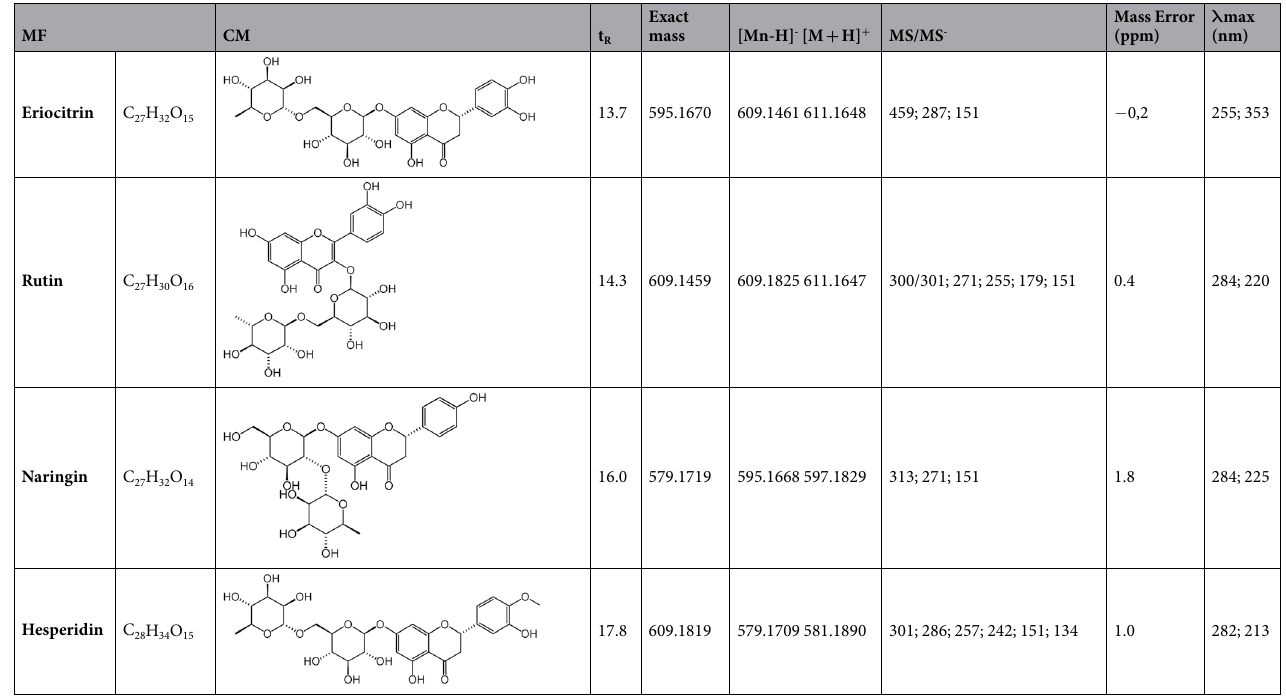
Table 1. Glycosylated flavonoids present in Tahiti lime juice by UPLC-DAD-MS/MS (Qq-TOF). MF: molecular formula. CM: chemical structure. t R : retention